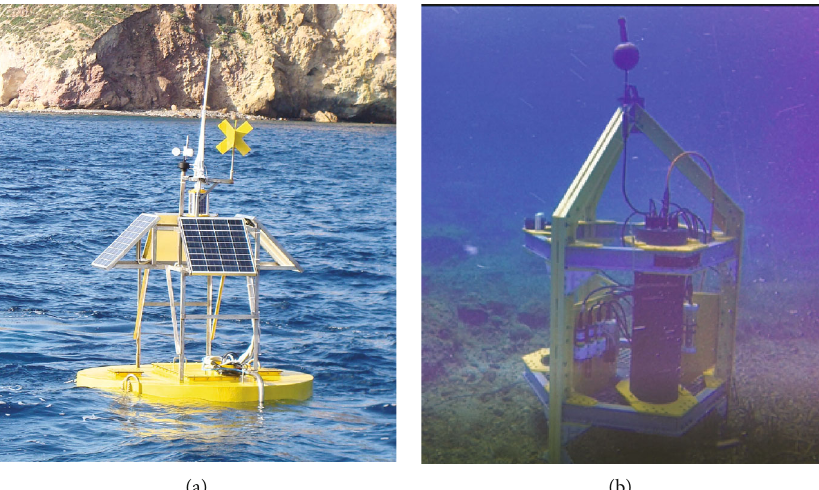
Figure 4: The multidisciplinary monitoring system operating within the main hydrothermal fi eld o ff shore Panarea: (a) surface buoy and (b) sea fl oor